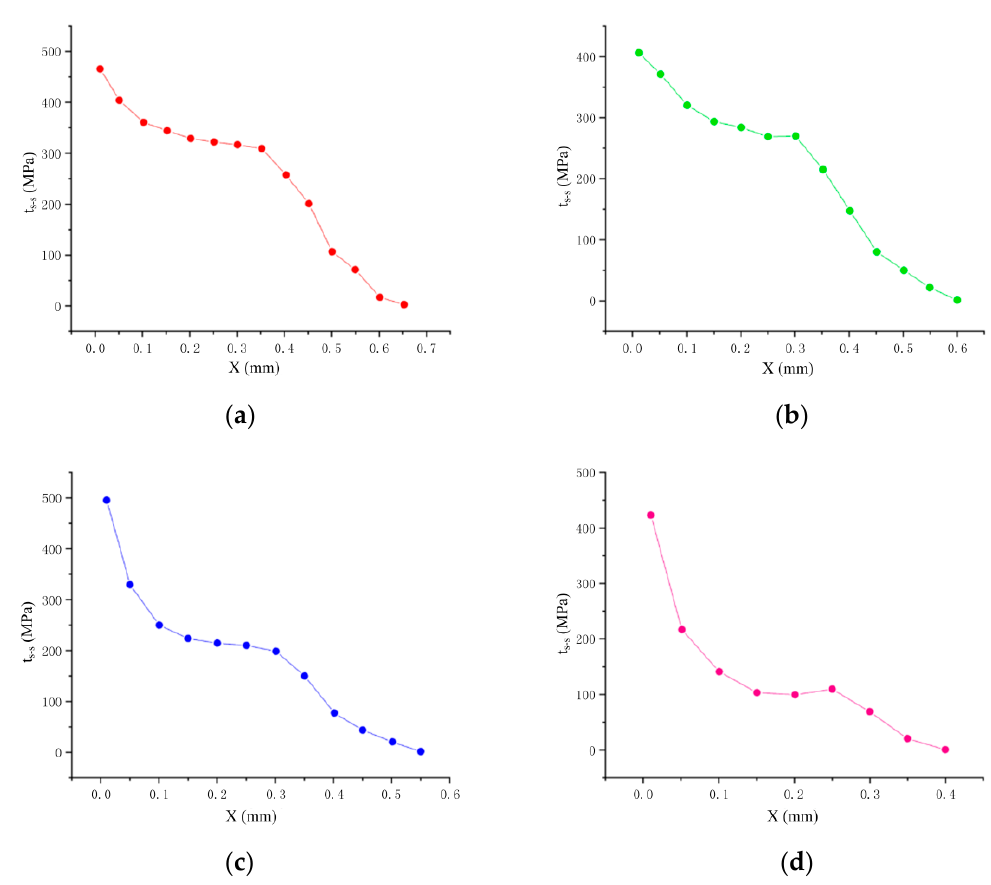
Figure 7. Distributed stress at the distance from cutting point to tool tip with different speed in the model. ( a ) V = 150 m/min; ( b ) V = 300 m/min; ( c ) V = 450 m/min; ( d ) V = 600 m/min.